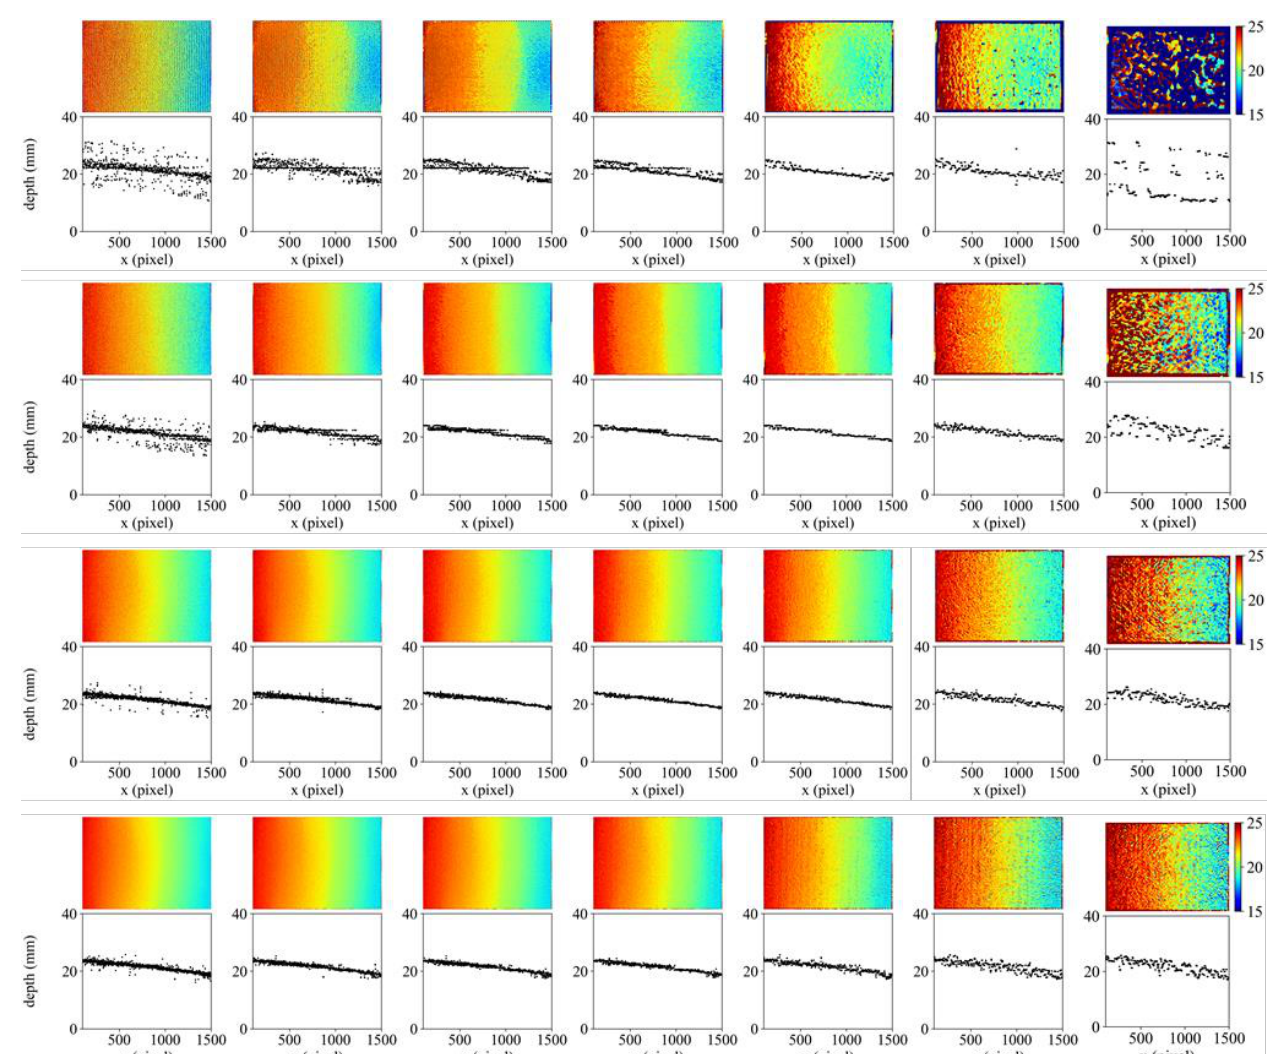
Figure 8. Results of depth measurements: 12 pixels (first row), 17 pixels (second row), 24 pixels (third row), 32 pixels (bottom), 1/4 λ (first column), 2/4 λ (second column), 3/4 λ (third column), 4/4 λ (fourth column), 6/4 λ (fifth column), 8/4 λ (sixth column), 12/4 λ (seventh column).